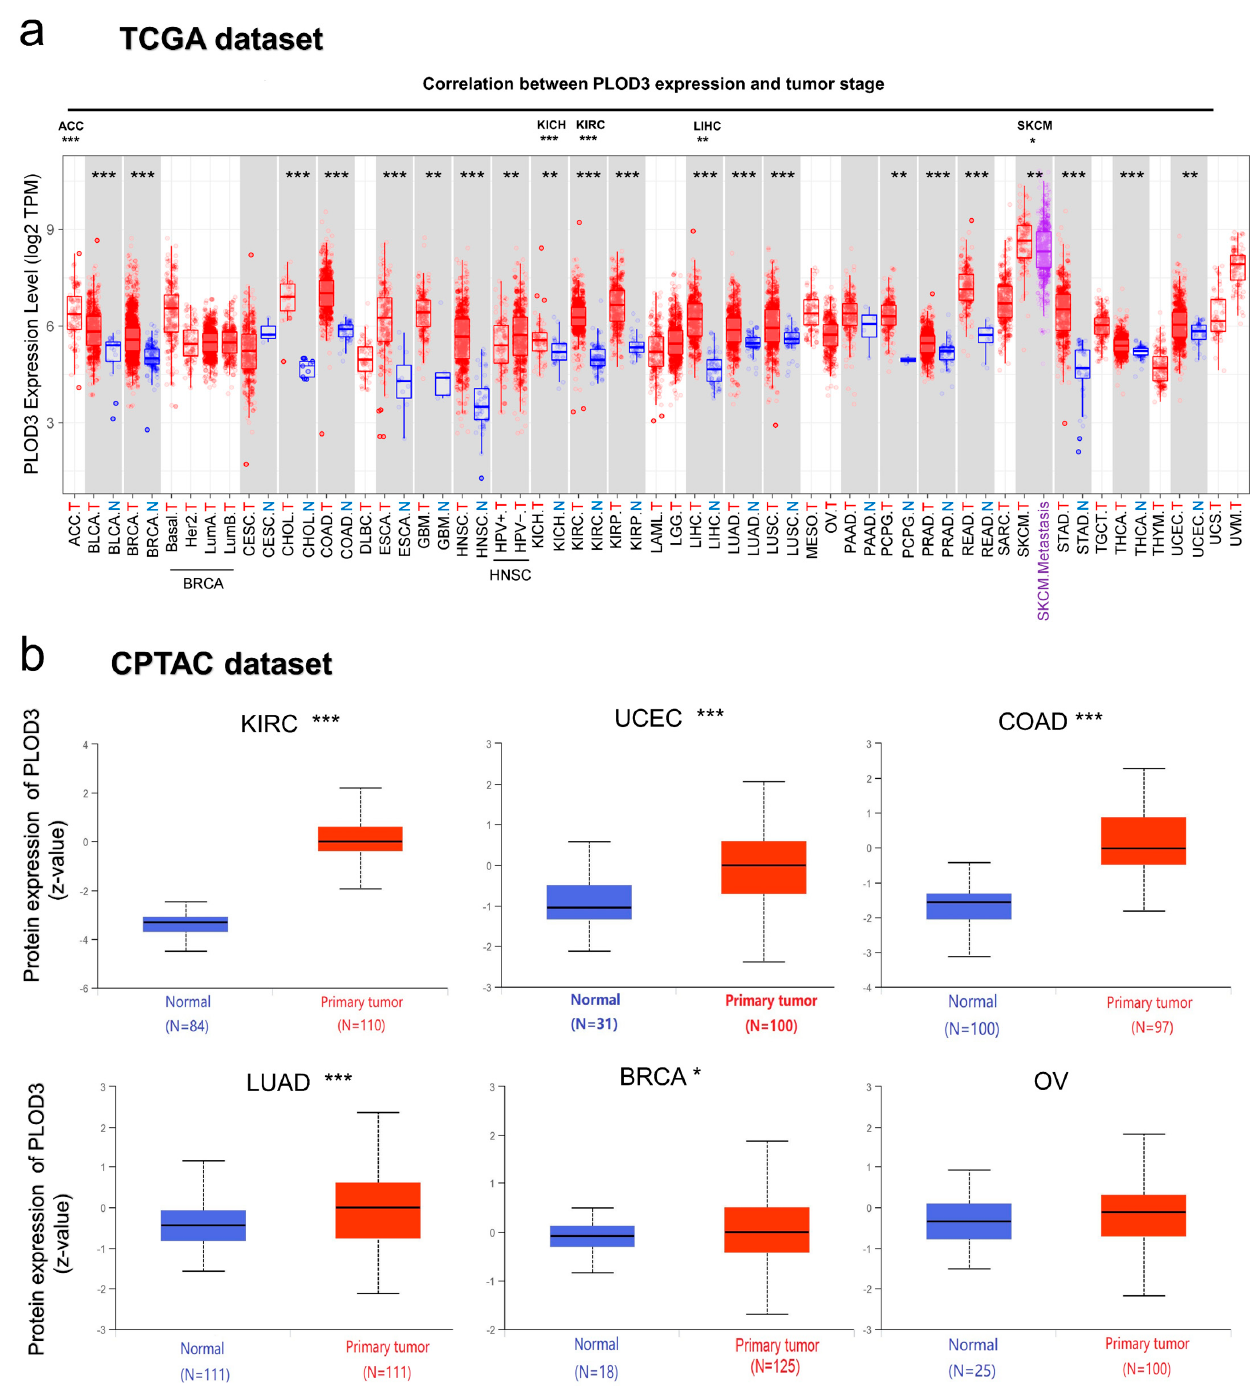
Figure 3. PLOD3 expression in different cancers. ( a ) The PLOD3 expression level in different cancers or specific cancer subtypes. N—normal and T—tumor tissue. ( b ) The PLOD3 total protein expression between tumor tissue and corresponding normal tissue according to the CPTAC dataset. * p < 0.05; ** p < 0.01; *** p < 0.001.